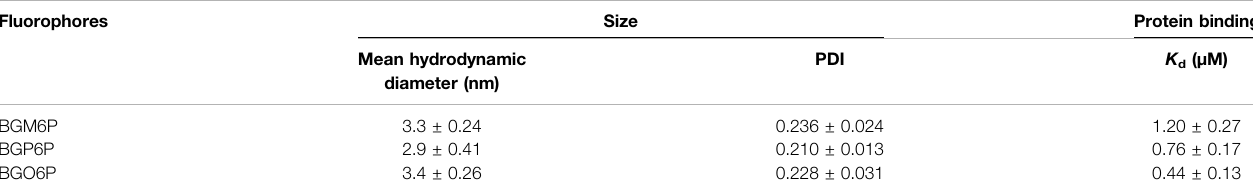
( Supplementary Figure S3 ). Similar fl uorescence spectra with emission maximum located at 1,013 nm are observed for all fl uorophores in toluene, and comparable QYs of ∼ 2.0% (QY of IR-26 with 0.05% in 1,2-dichloroethane as reference) are determined.